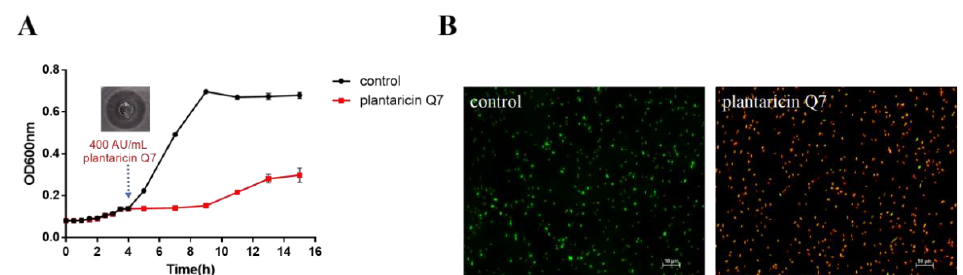
Figure 1. Antibacterial activity of plantaricin Q7 against L. monocytogenes . ( A ) Effect of plantaricin Q7 on the growth curve of L. monocytogenes . ( B ) Effect of plantaricin Q7 on the survival rate of L. monocytogenes . The data were shown as mean ± SD ( n = 3).